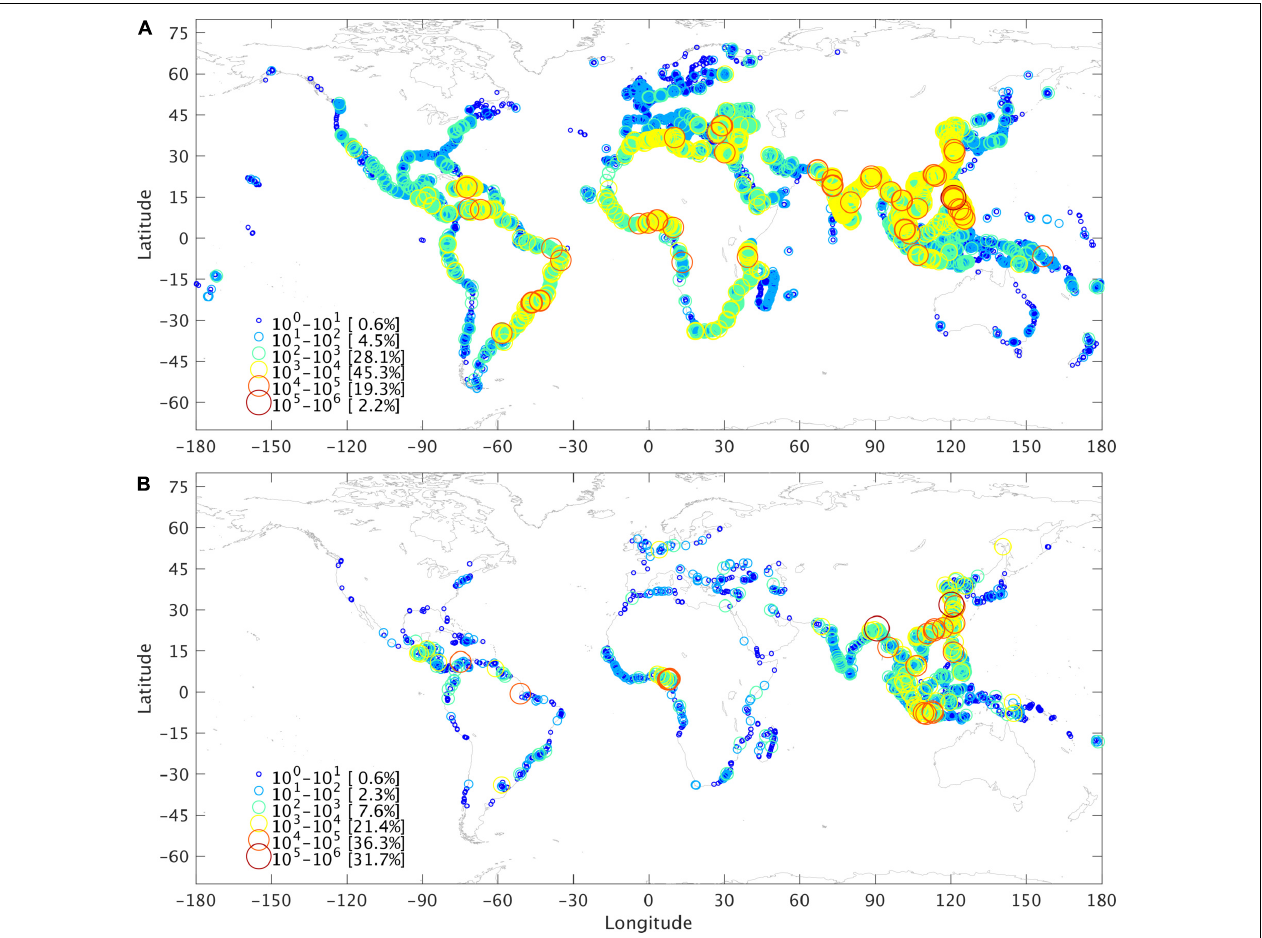
FIGURE 1 | Distribution of the annual mismanaged plastic waste input from (A) the coastal regions (50 km from the coastline) based on Lebreton and Andrady (2019) and (B) the inland regions through rivers based on Lebreton et al. (2017). Blue to red circles with increasing size represent mismanaged plastic waste of different order of weights (in tons/year) and their percentage values with respect to the total ( ∼ 5.1 Million tons/year for the coastal regions and ∼ 1.4 Million tons/year for the inland